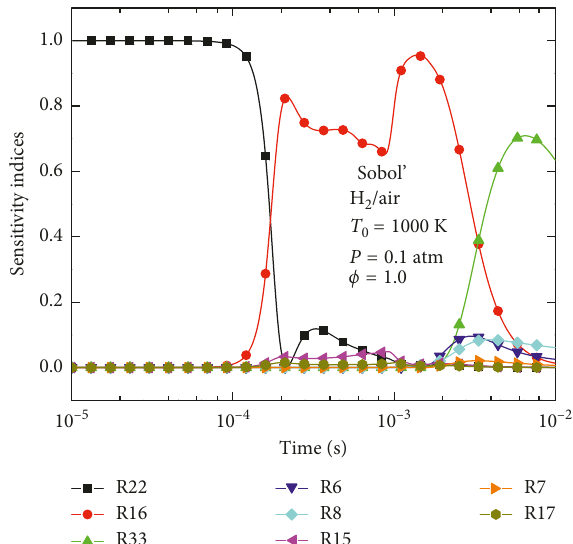
Figure 3: The profiles of sensitivity indices measured by Sobol’s method with 20,000 sample size.